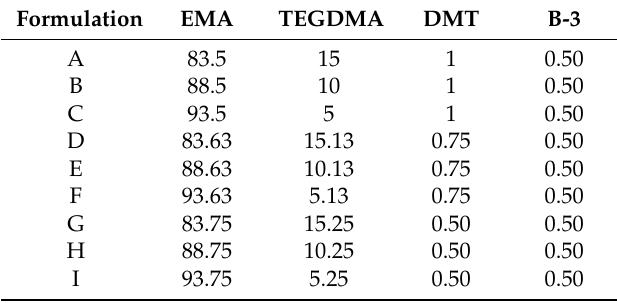
Table 1. Liquid formulations prepared and their composition in mass